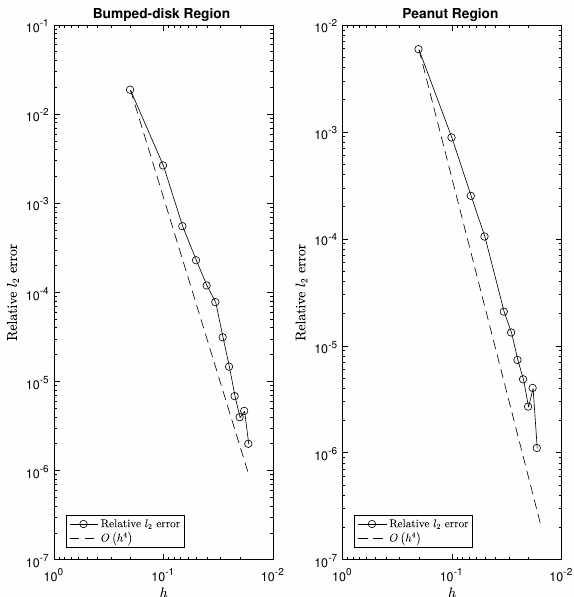
Figure 20. Solution convergence for the diffusion equation with forcing term using optimized